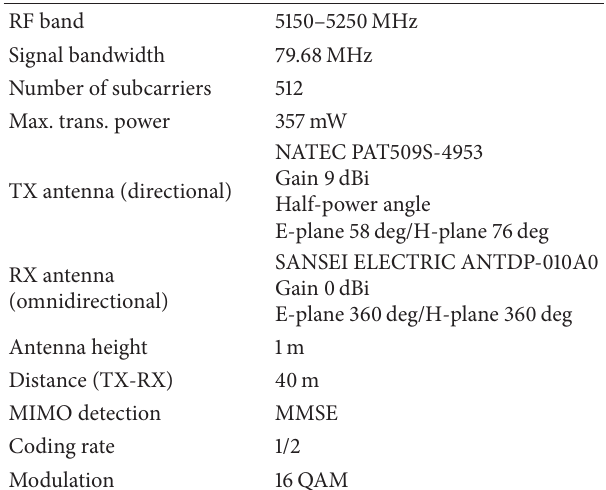
Table 1: Experimental